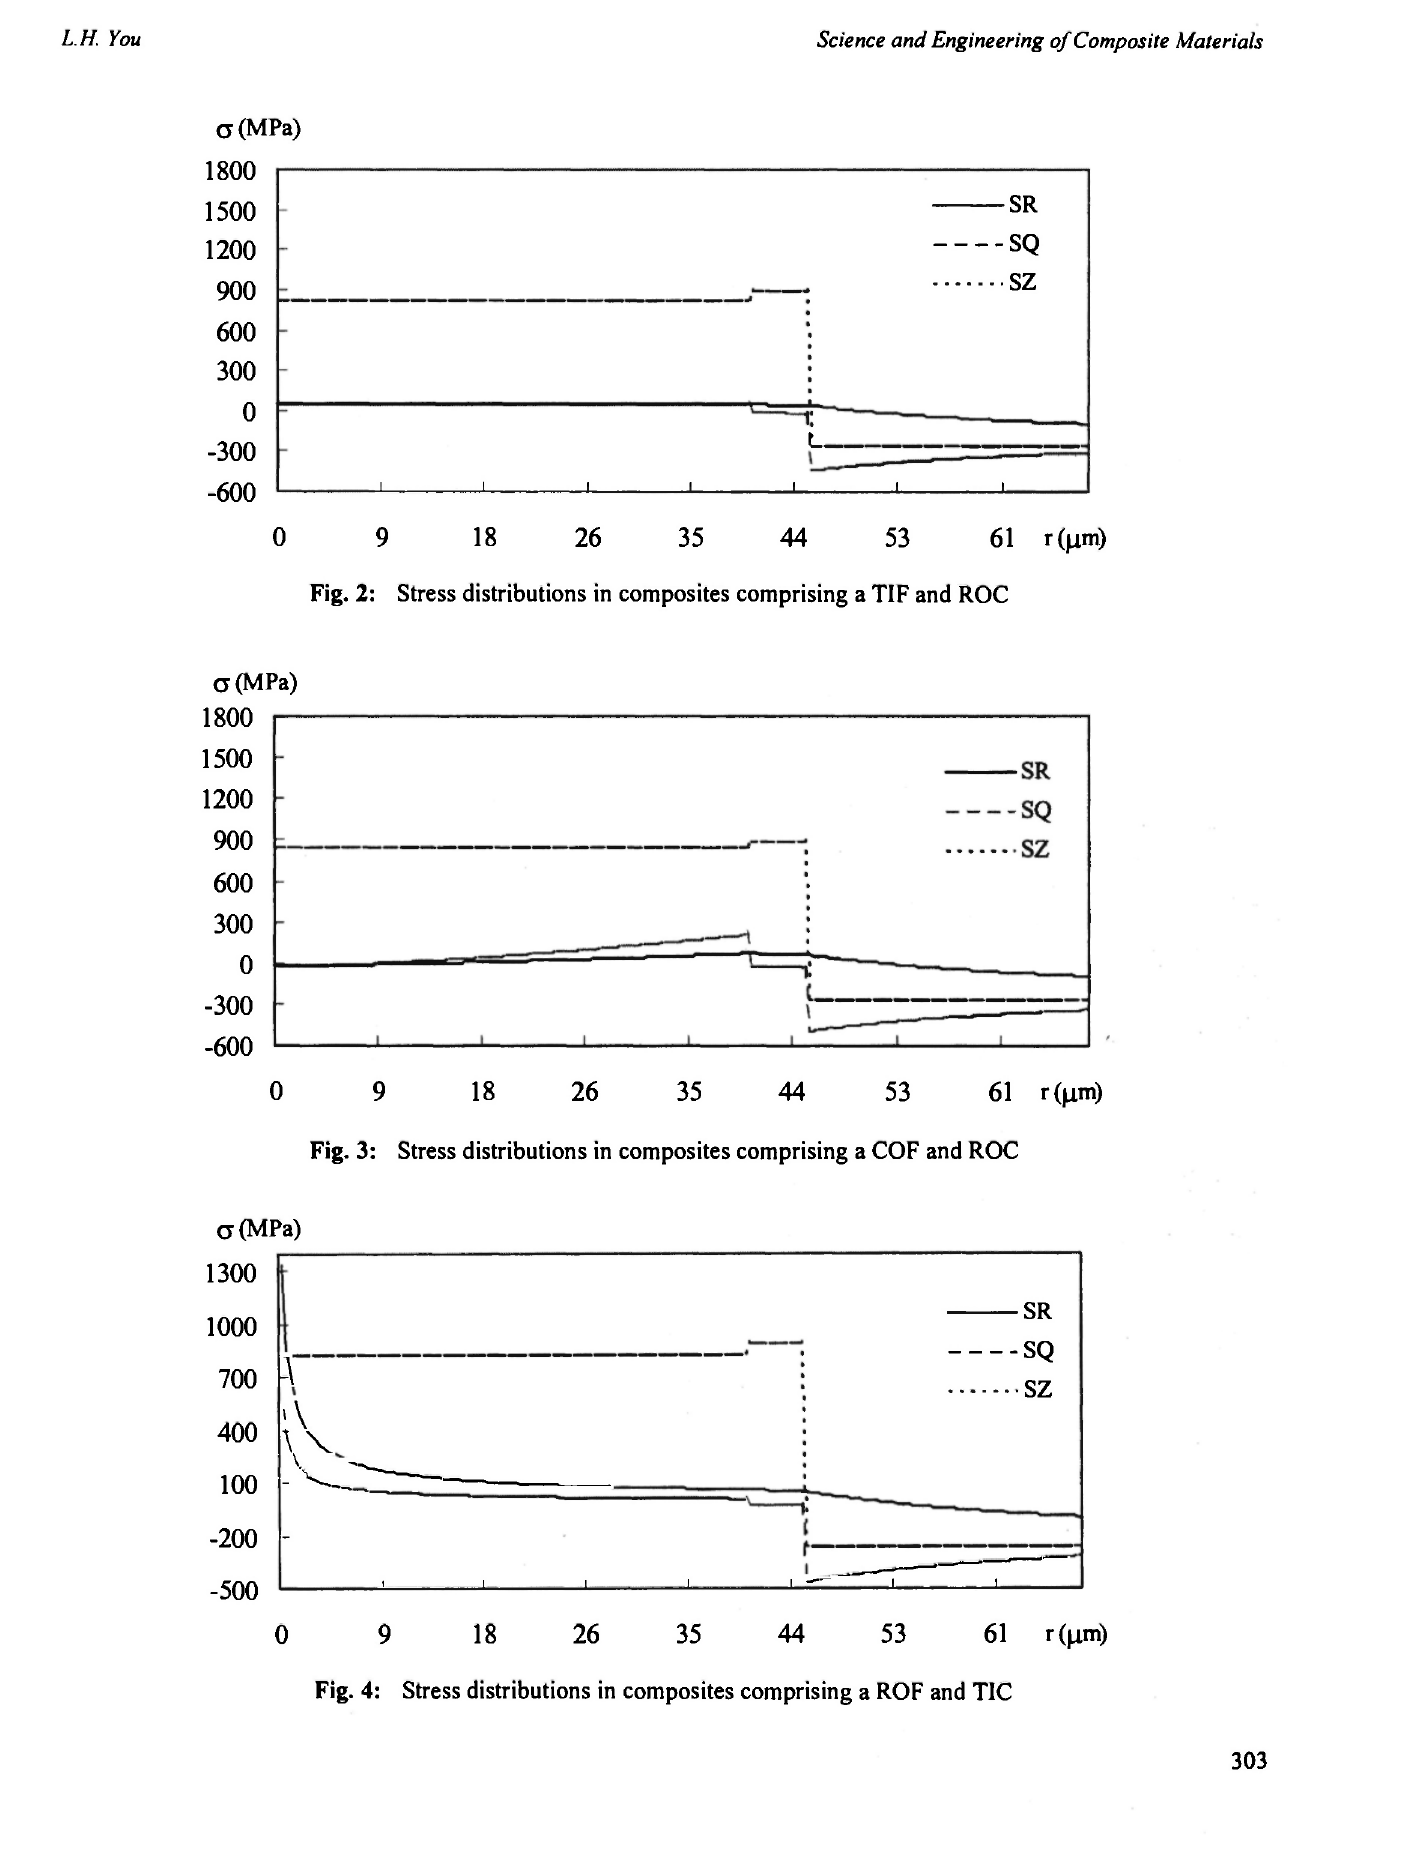
Fig. 4: Stress distributions in composites comprising a ROF and